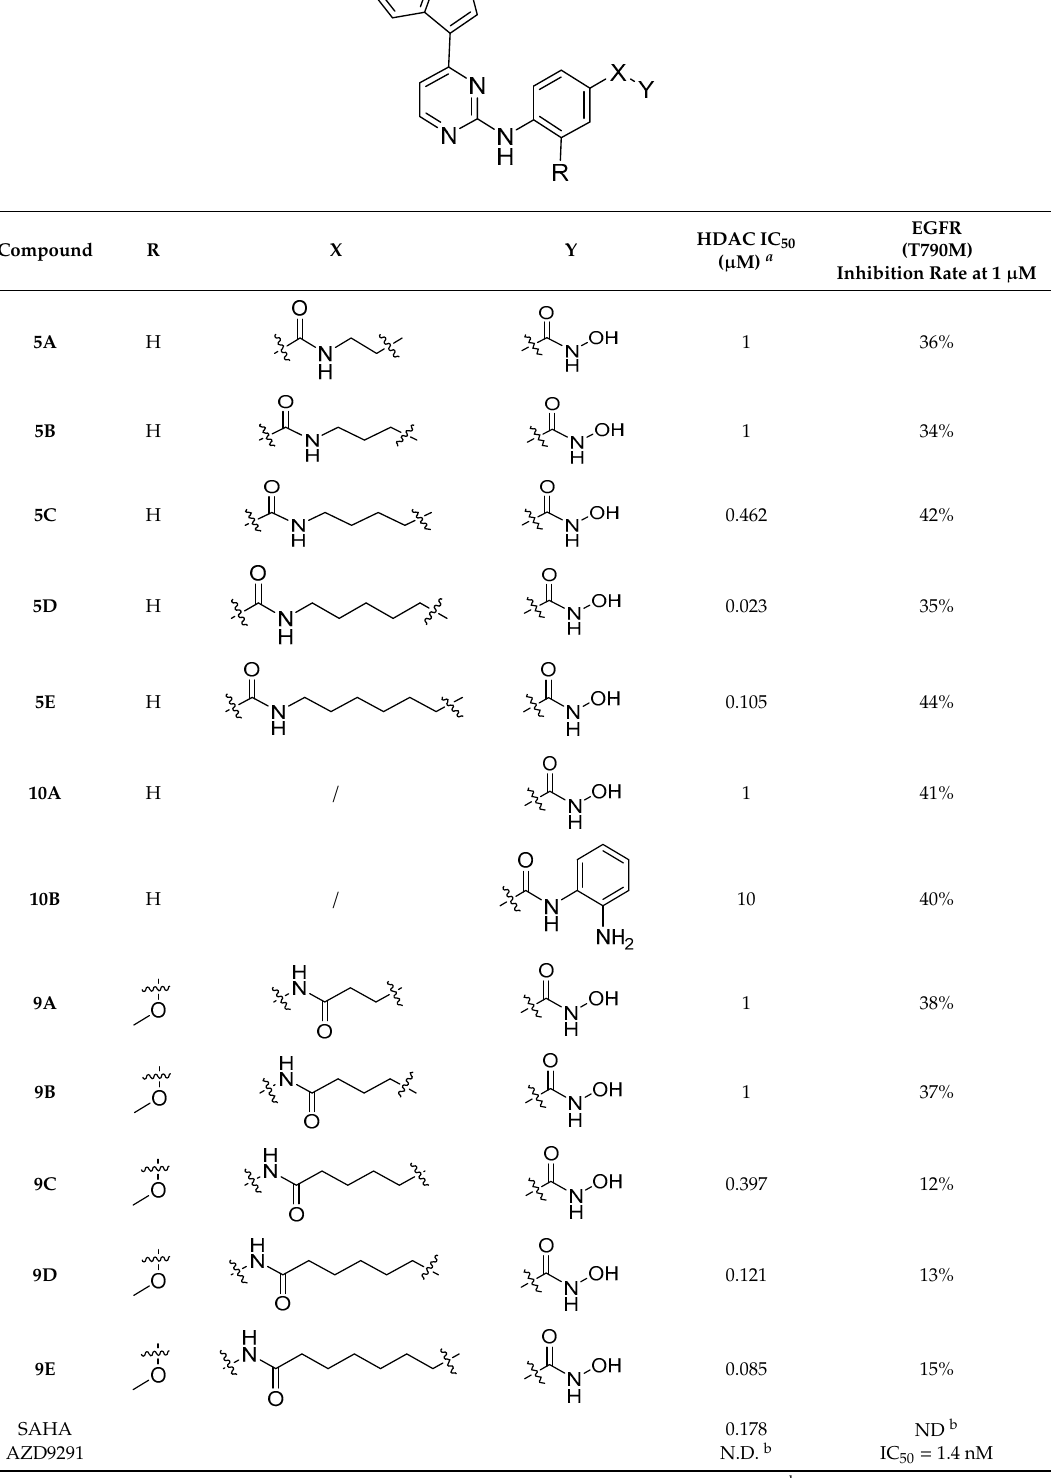
Compound Compound